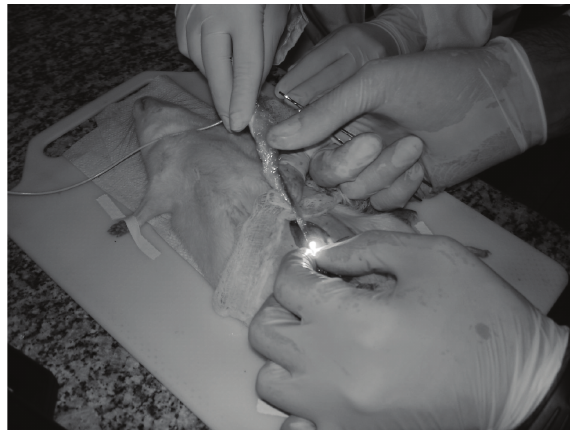
Figure 2: Fluorescence spectra acquisition in dimethylhydrazine- induced murine colorectal carcinoma.